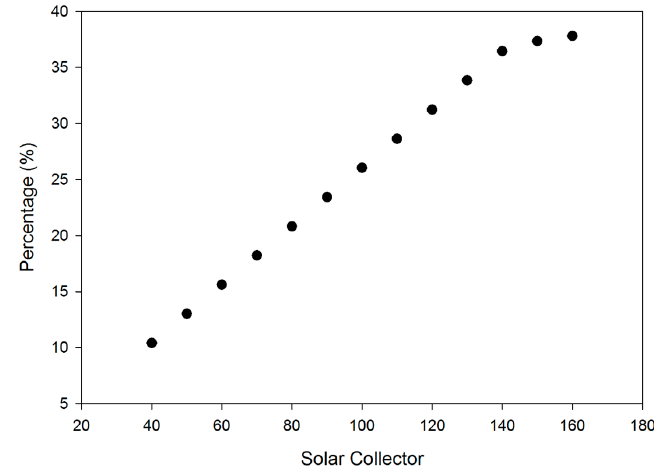
Figure 12. Percentage of the building load supplied by the ORC-EES verses number of solar collectors for a restaurant in Tucson, AZ. Energies 2018 , 11 , x FOR PEER REVIEW